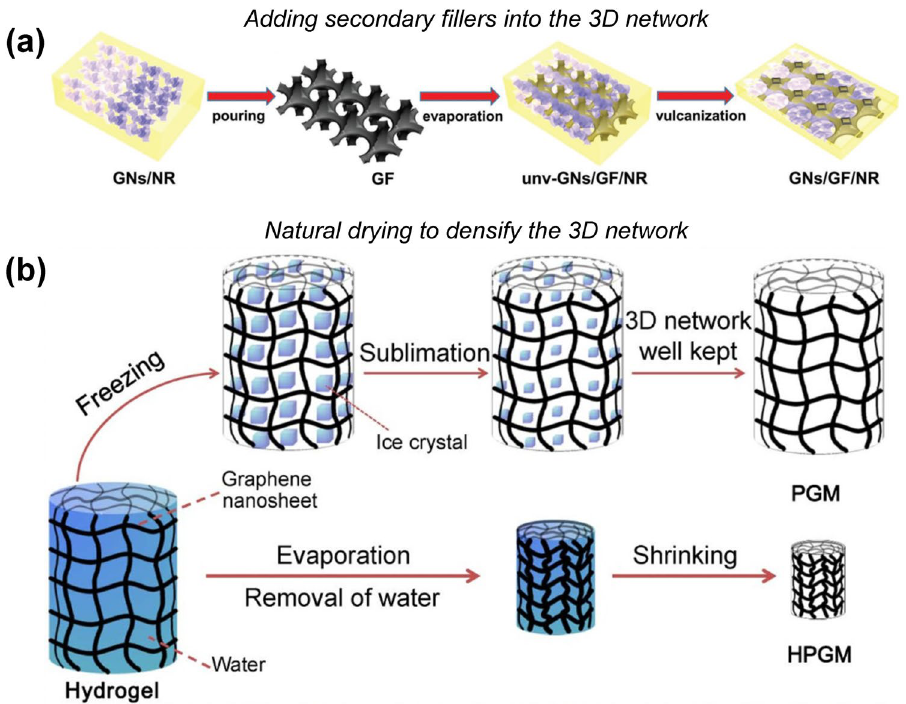
Fig. 5 a Schematic illustration of GNs/GF/NR composites with compact network [75]. b Comparison of freeze‑drying and air‑drying